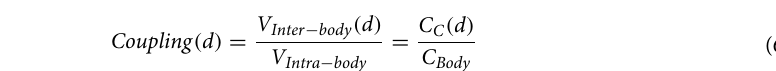
Table 2. Minimum SNR required for operating at three different intended uncoded bit error rate (BER) in the cases of PAM 2, QPSK and 16-QAM modulation techniques 18 .